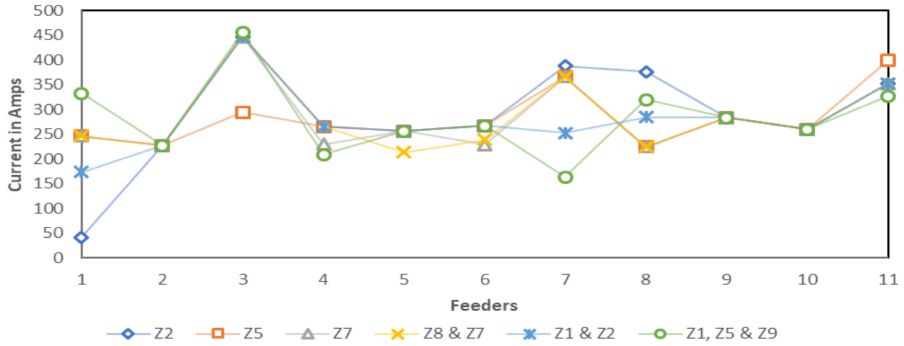
Figure 15. Distribution of feeder under di ff erent fault conditions.